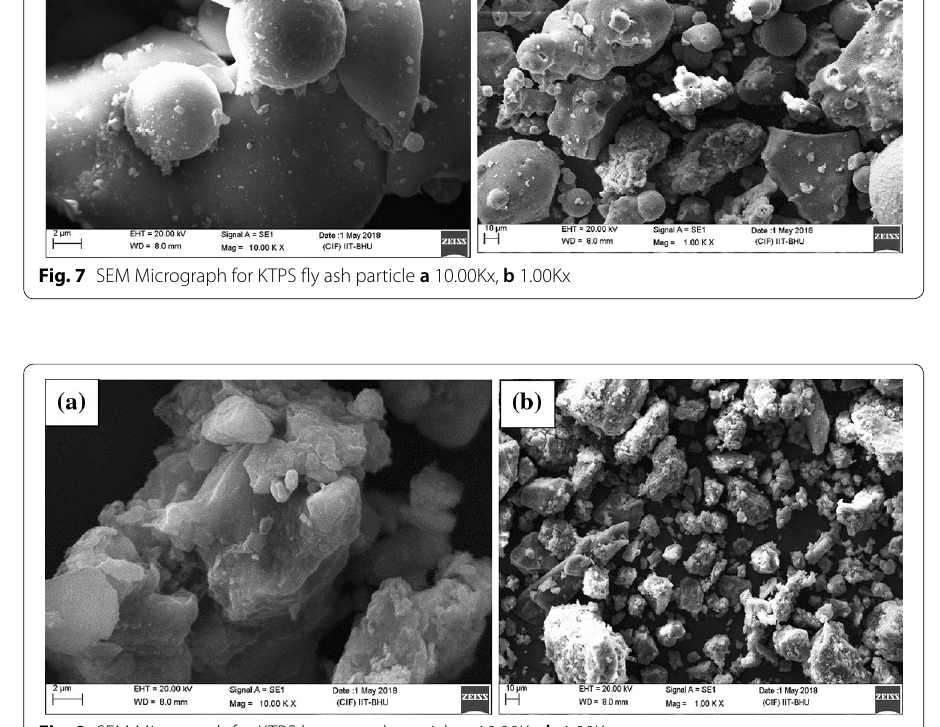
Fig. 8 SEM Micrograph for KTPS bottom ash particle a 10.00Kx, b